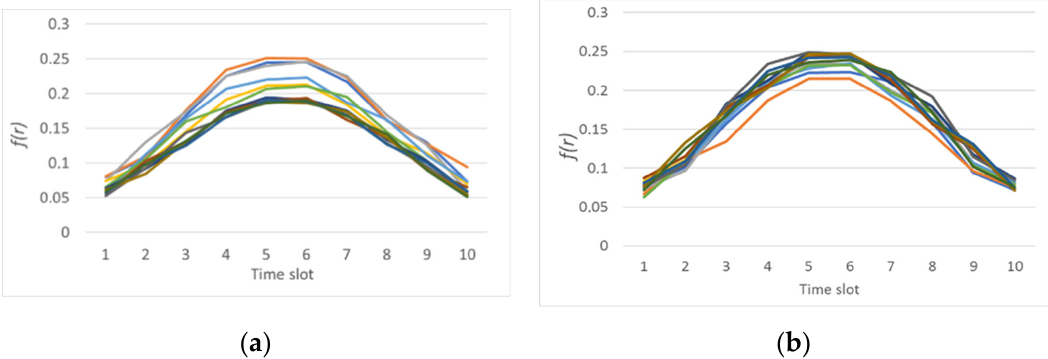
Figure 6. The result of calculating the normal distribution function for incoming traffic of: ( a ) node i with additional payload; and ( b ) node j in normal mode.